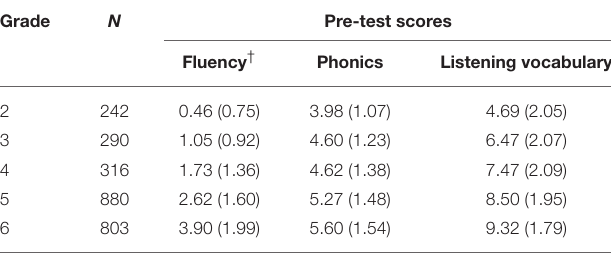
TABLE 2 | Average pre-test scores obtained for District 1, separated by